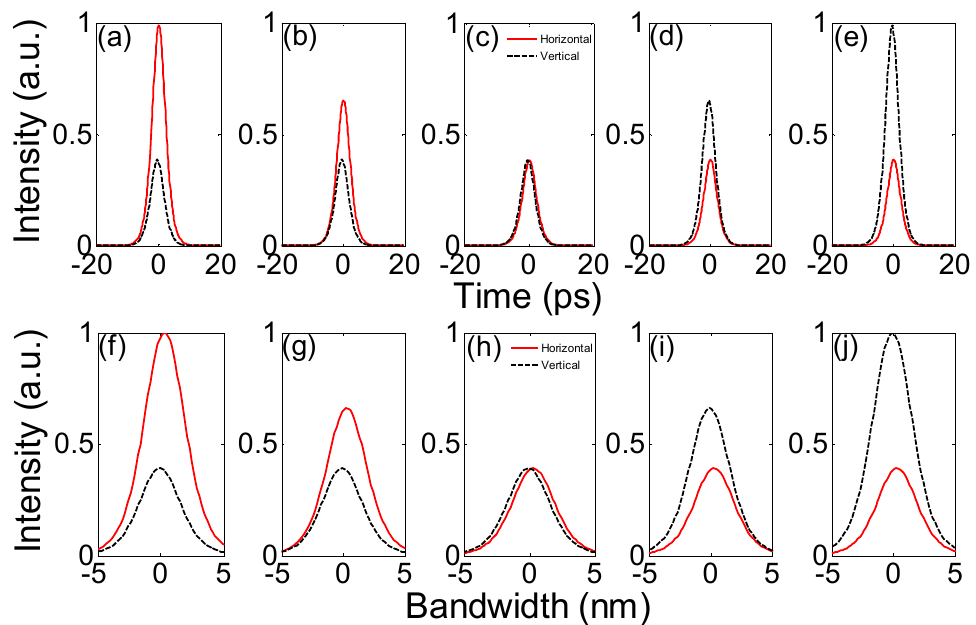
Figure 2. Theoretical results after polarization splitting when the amplitude ratio between orthogonal modes is changed and λ 1 = λ 2 = 1064 nm.